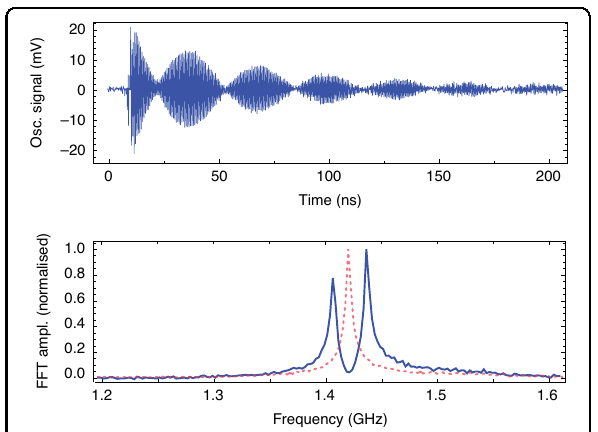
Fig. 6 The Zeeman effect. (Top) Experimental SPH magnetization beating trace, with a transverse magnetic fi eld of 10.76±0.01G. Notice the slow beating with a period of ∼ 30ns, caused by the beating of two frequencies. (Bottom) FFT of the top trace, showing that the trace (red dashed) without a magnetic fi eld is split into two peaks (blue solid), due to the Zeeman effect. Clearly, this splitting, and the magnetic fi eld strength, can be determined on the ns timescale